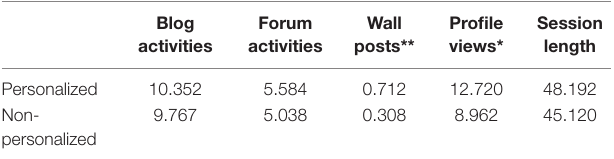
TaBle 5 | sessions with feed clicks: